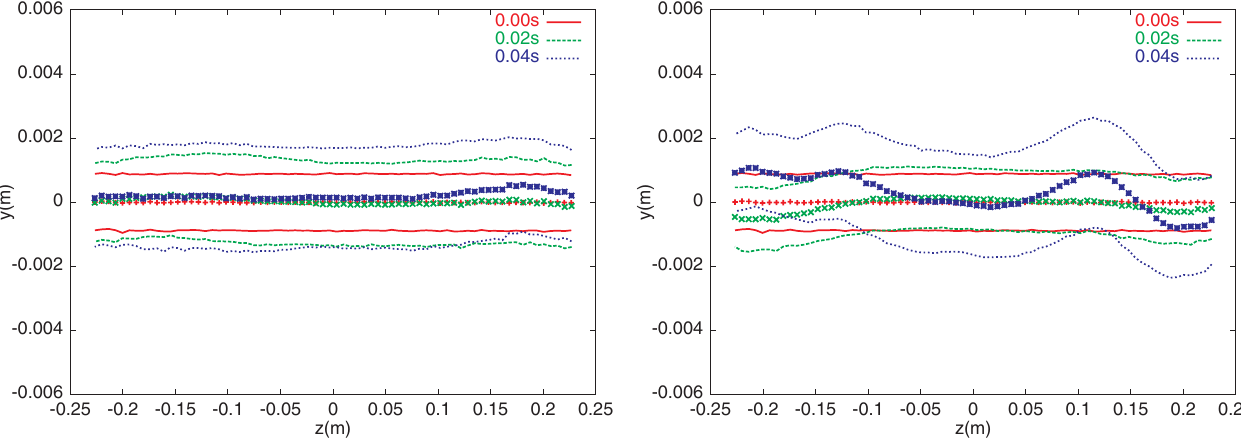
FIG. 5. (Color) Snapshot of the vertical bunch shape (centroid and rms size) at different time steps assuming 1 IP (left) and 5 IPs (right) per